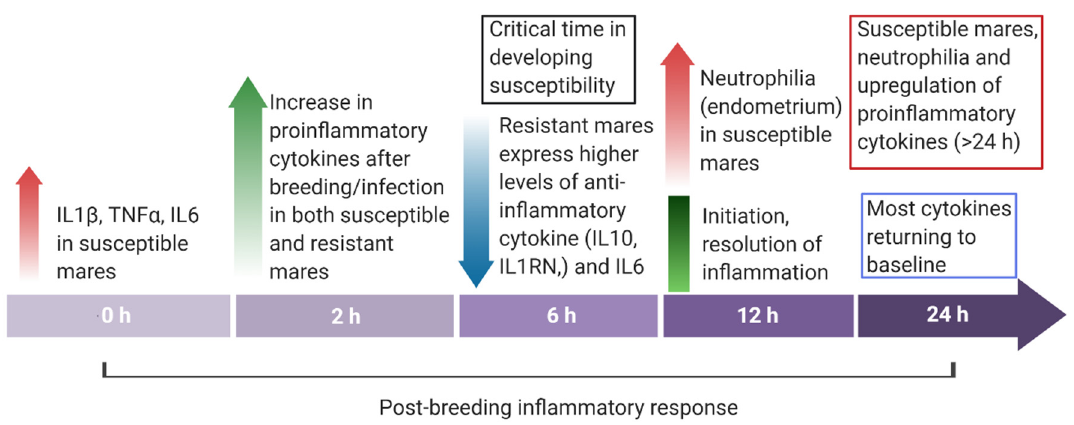
Figure 3. Overview of the endometrial cytokine dynamics in mares resistant and susceptible to endometritis from immediately before (0 hours) to 24 hours post-breeding.